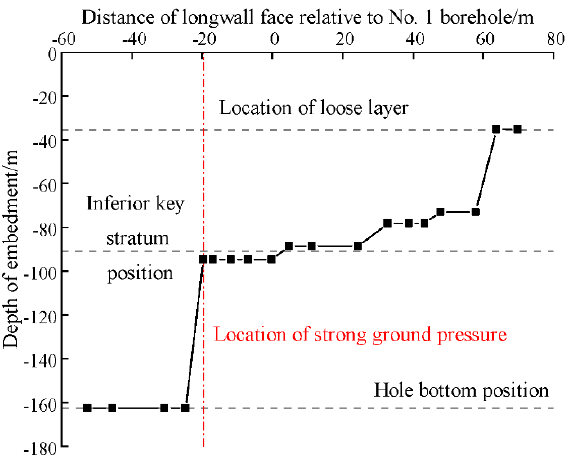
Figure 6. Relationship between the depth of misaligned holes in No. 1 borehole and the distance of longwall face relative to No. 1 borehole.